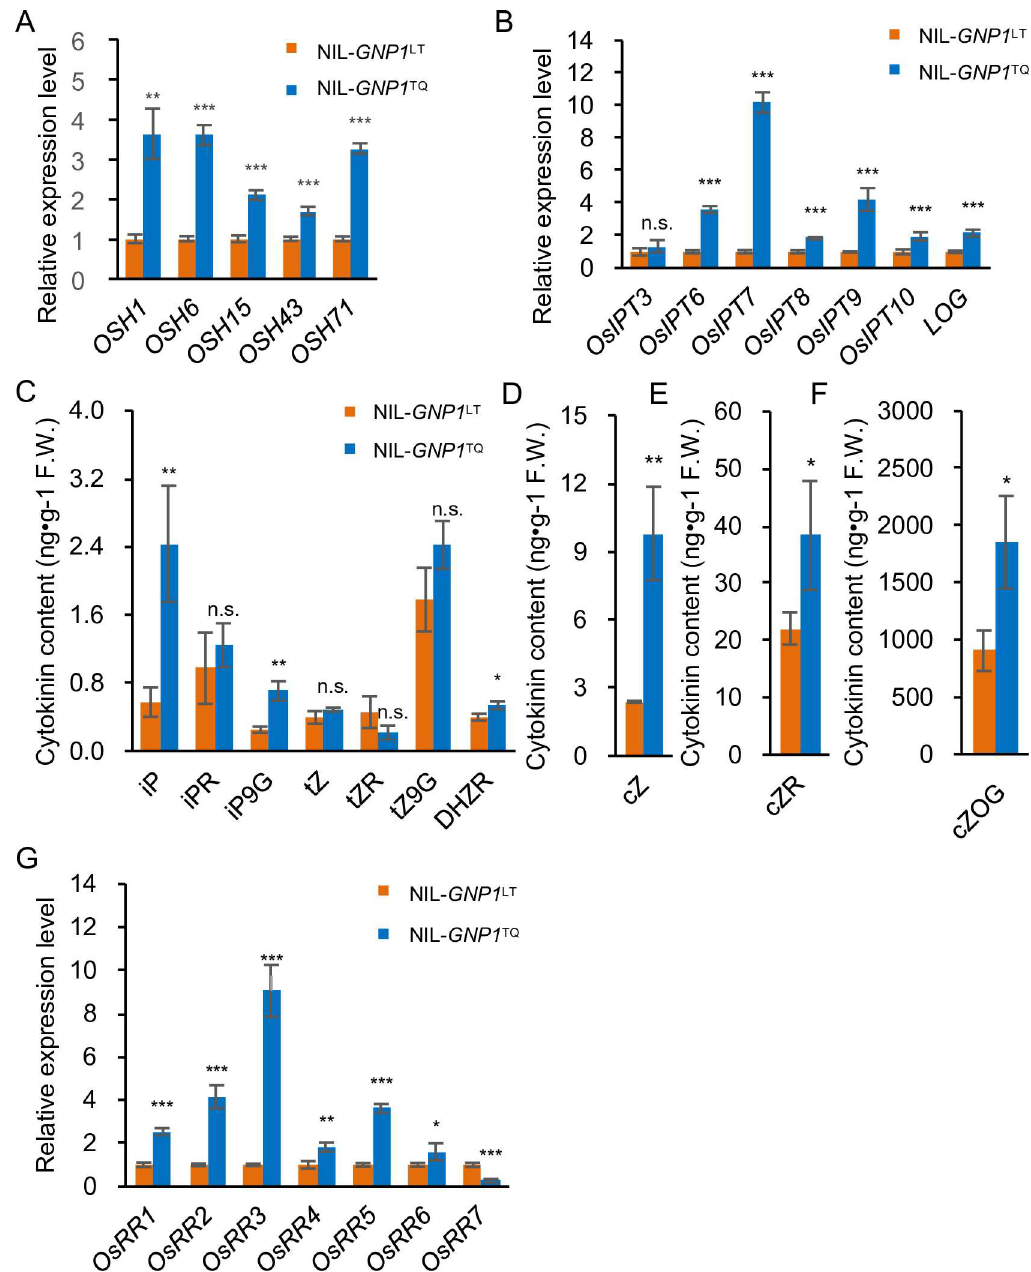
Fig 6. GNP1 TQ allele activatescytokinin biosynthesis and the cytokinin signal transduction pathway. (A) Relativeexpressionlevels of rice KNOX genes in young NIL- GNP1 LT and NIL- GNP1 TQ panicles(~1 cm) at early panicleinitiationto booting stage. Values are means ± s.d. (n = 4, each with 6 plants). (B) Relative expression levels of rice cytokinin biosynthesis-relatedgenes in young NIL- GNP1 LT and NIL- GNP1 TQ panicles(~1 cm) at early panicle initiationto bootingstage. Values are means ± s.d. (n = 4, each with 6 plants). (C–F) Comparison of endogenous cytokinin levels between young NIL- GNP1 LT and NIL- GNP1 TQ panicles(~1 cm) at early panicle initiationto booting stage. Values are means ± s.d. (n = 3, each with 8 plants). Orange columns, NIL- GNP1 LT ; blue columns, NIL- GNP1 TQ . (G) Relative expression levels of cytokinin signaltransduction-related genes in young NIL- GNP1 LT and NIL- GNP1 TQ panicles(~1 cm) at early panicle initiationto booting stage. Values are means ± s.d. (n = 4, each with 6 plants). Asterisks represent significant difference determinedby Student’s t-test at p -value < 0.001 ( *** ), p - value < 0.01 ( ** ), p -value < 0.05 ( * ), not significant